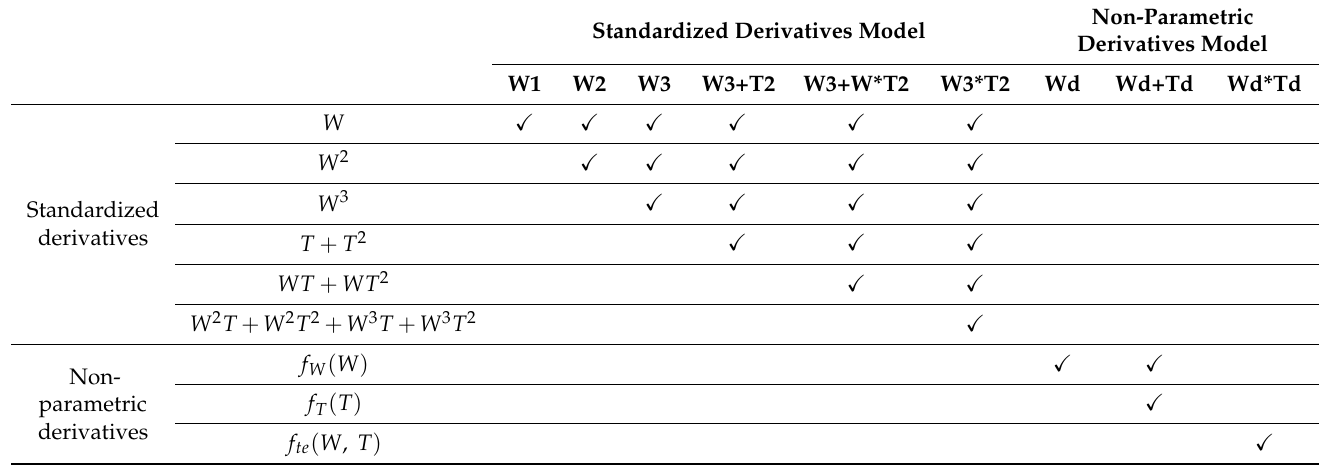
Figure 5. Hedge effects of standardized derivatives and non-parametric derivatives. Table 1. Components of hedging instruments by hedging